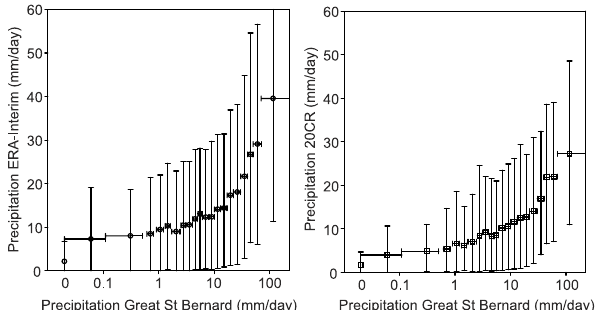
Fig. 2. Comparison of daily precipitation in observations from the Great St Bernard and from ERA-Interim (left) and 20CR (right) re- analysis data in the period 1980–2008. Observed precipitation was binned (horizontal error bars indicate the bin size). The y axes give the average precipitation for each bin (error bars give the 10th and 90th